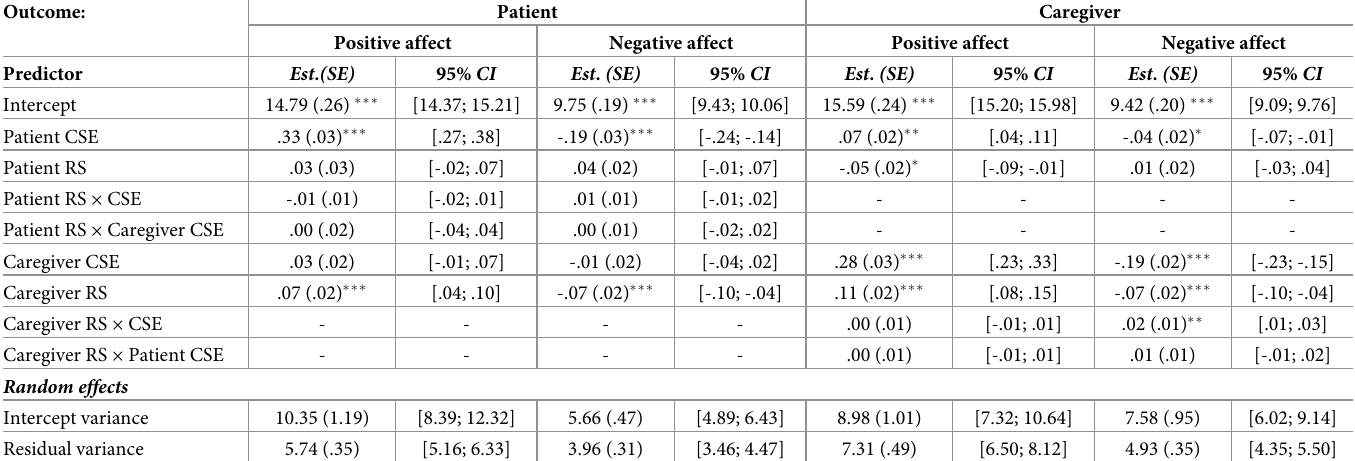
Table 2. Results of concurrent analysis: The fixed effects of daily coping self-efficacy (CSE), received support (RS), and their interaction on same-day affect in 200 patient-caregiver dyads. Outcome: